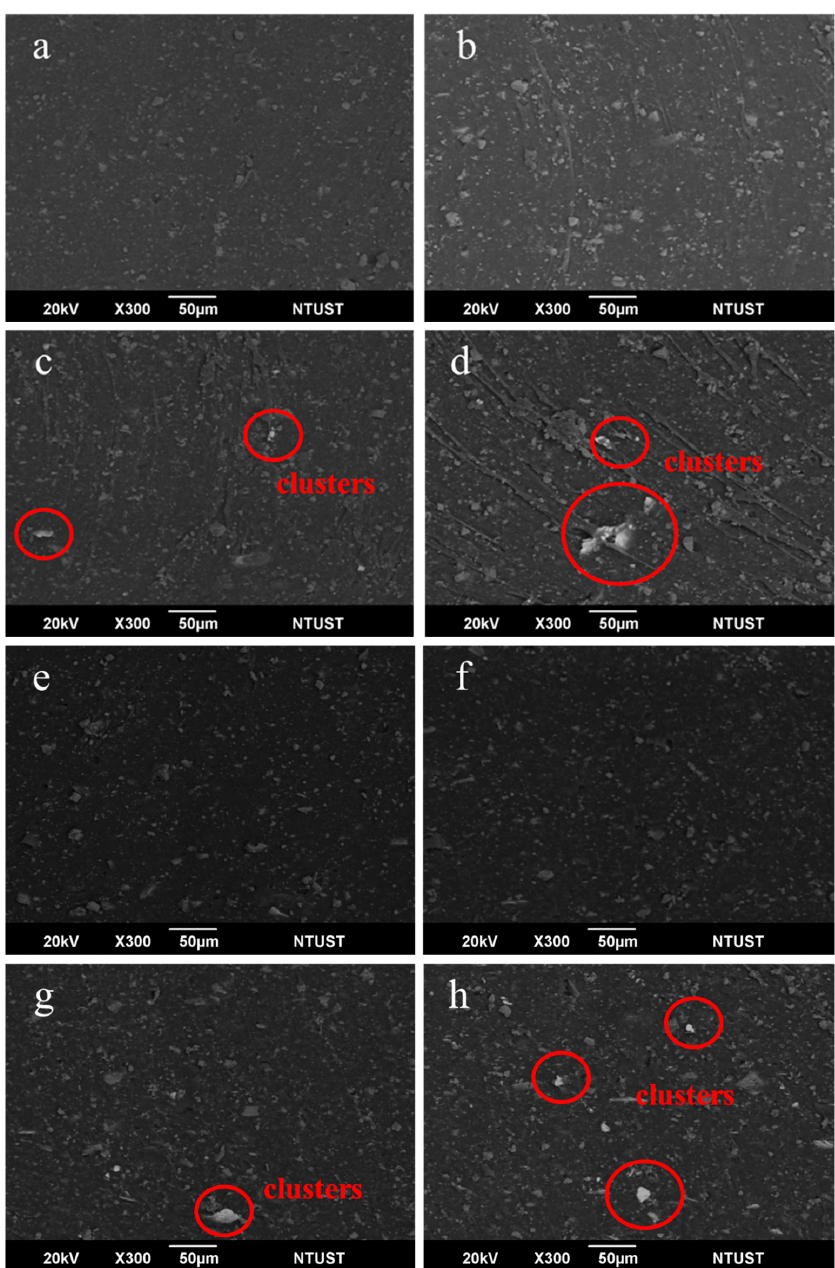
Figure 6. Scanning electron microscope backscattered electrons (SEM-BSE) cross-sectional images for MoS 2 -butyl rubber with different concentrations of MoS 2 with either ethanethiol or nonanethiol: ( a ) 0.5 phr, ethanethiol; ( b ) 1 phr, ethanethiol; ( c ) 3 phr, ethanethiol; ( d ) 5 phr, ethanethiol; ( e ) 0.5 phr, nonanethiol; ( f ) 1 phr, nonanethiol; ( g ) 3 phr, nonanethiol; and, ( h ) 5 phr, nonanethiol. The typical Raman peaks for MoS2-butyl rubber nanocomposites are shown in Figure 7. The peaks at ~380 and ~410 cm − 1 correspond to MoS2, while the peaks at ~720, ~820, ~910, and ~1080 cm − 1 correspond to chlorobutyl rubber. Raman mapping (Figure 8) was used to further confirm the dispersion state of MoS 2 nanosheets at different MoS 2 concentrations. Figure 8 shows the intensity maps of the A 1g peak (~410 cm − 1 ) of MoS 2 for nanocomposites with different concentrations of modified MoS 2 nanosheets. The Raman mapping images correspond well with the SEM-BSE images (Figure 6). At low concentrations of MoS 2 nanosheets, their distribution was